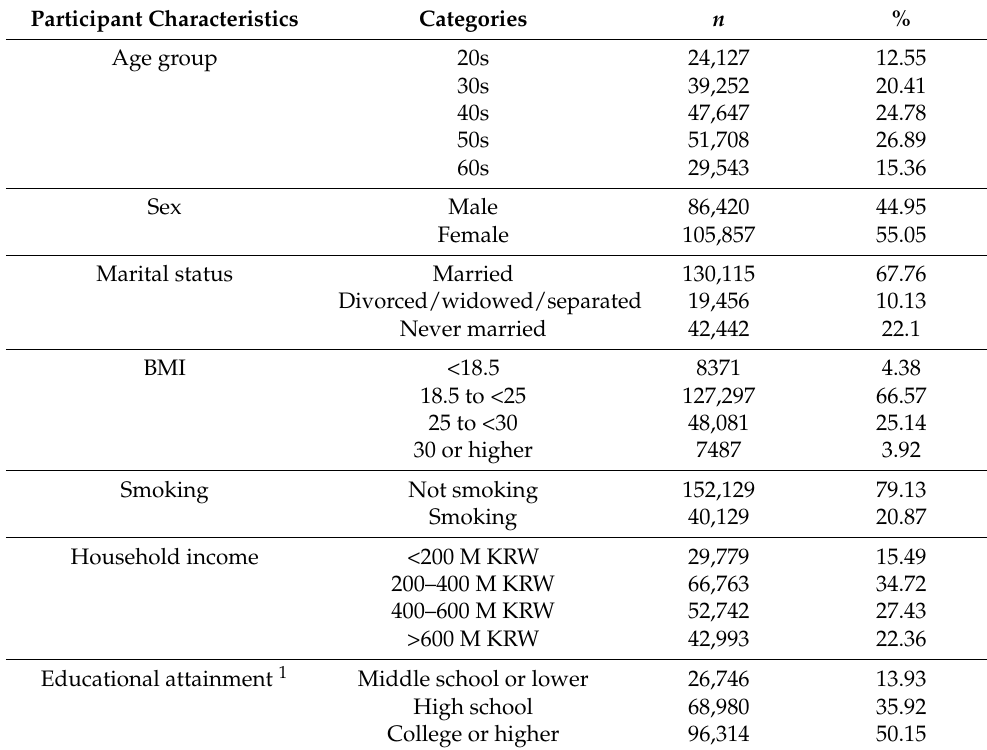
Table 1. Description of study